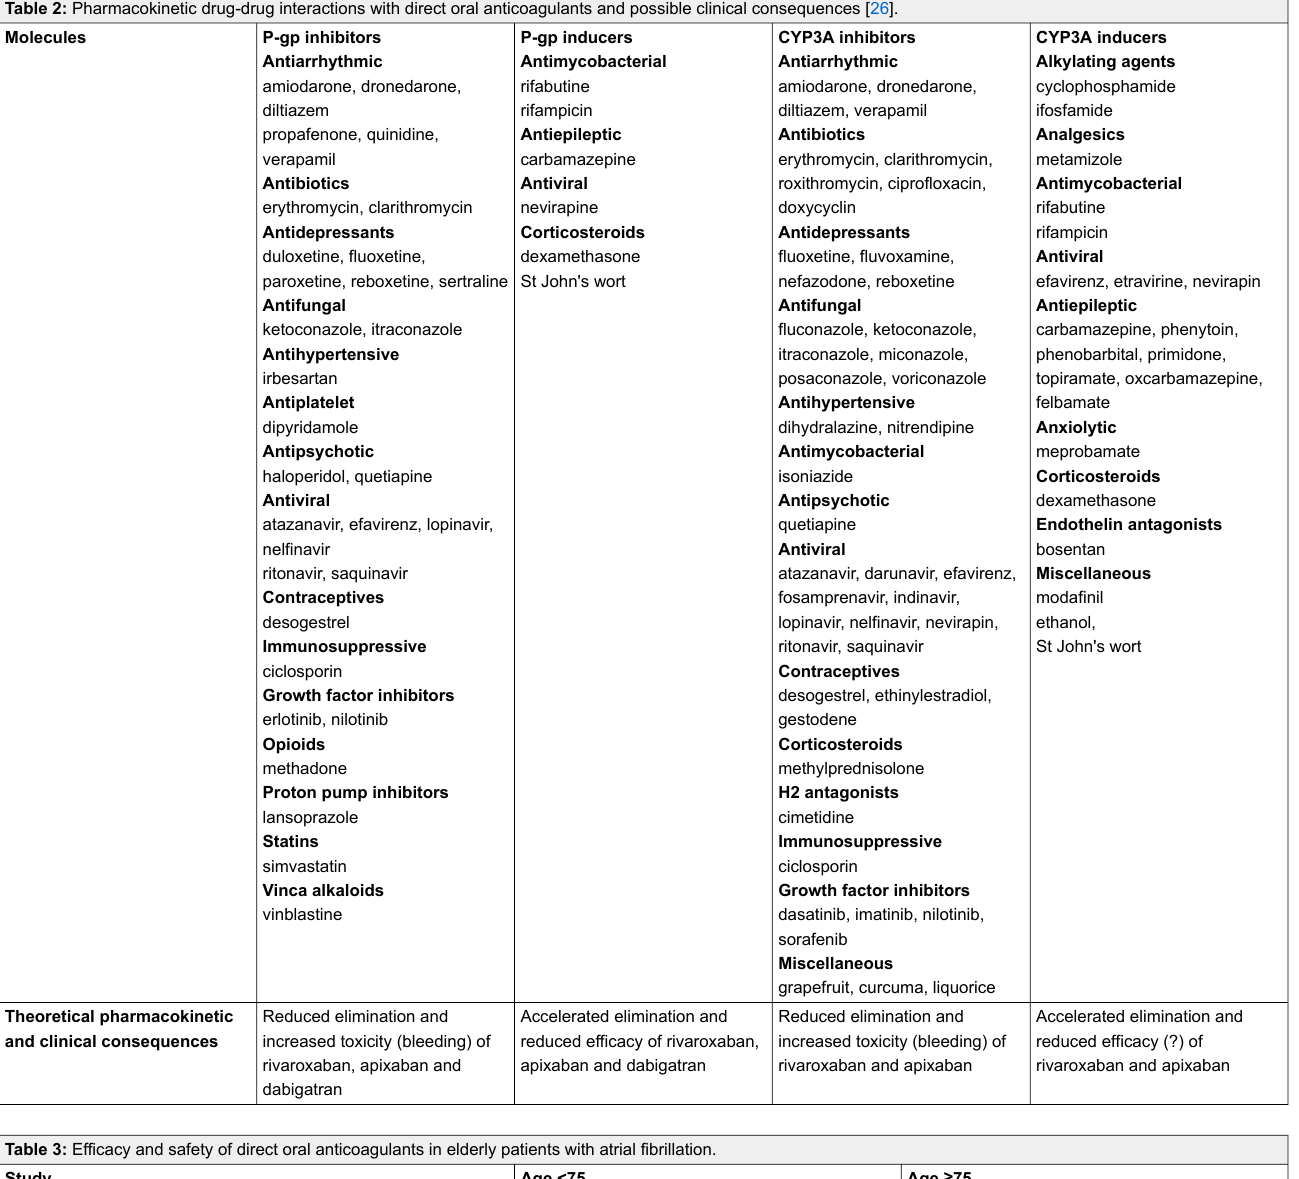
Table 2: Pharmacokinetic drug-drug interactions with direct oral anticoagulants and possible clinical consequences [26]. Molecules